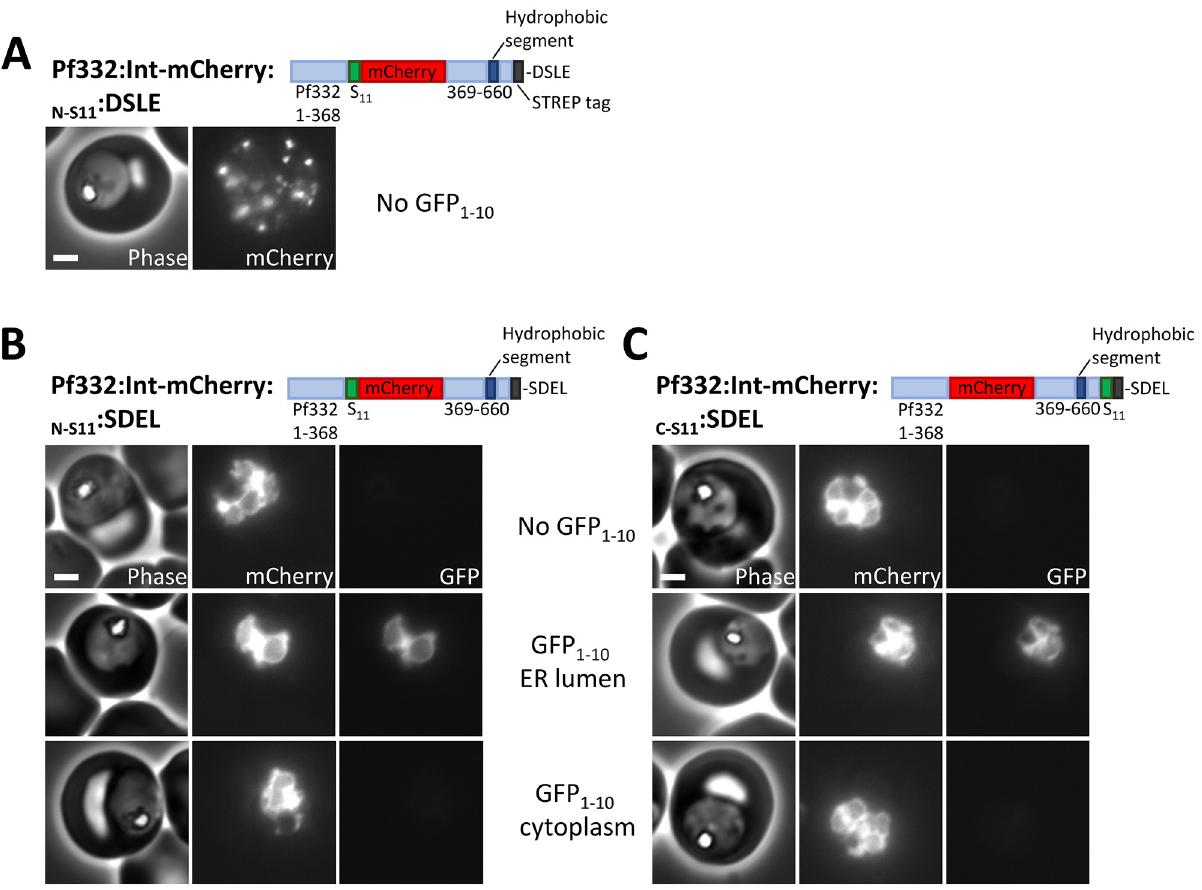
Fig 2. ER-lumenal localisation of ER-retained Pf332. (A-C) Phase contrast and fluorescence images of parasites expressing the indicated Pf332 proteins either alone or with the indicated GFP 1-10 proteins. Scale bar: 2 μ m.